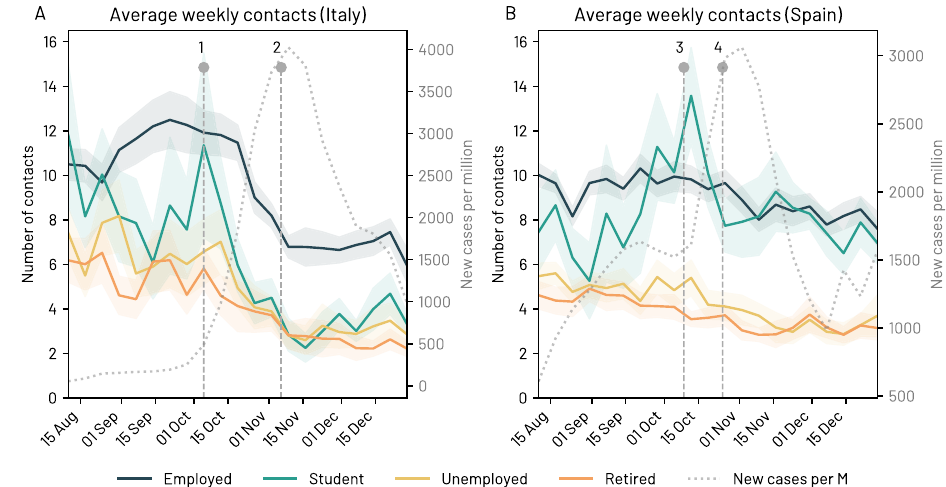
Figure 2. Average estimated number of weekly close contacts from outside the household together with the number of daily coronavirus infections (dotted curve) in Italy (A) and Spain (B) . We highlight in the plots several notable events: (1) the Italian compulsory mask mandate in public spaces; (2) the imposition of the three-tiered system in Italy; (3) the Spanish declaration of state of alarm in the Comunidad de Madrid; and (4) the declaration of state of emergency in Spain. We report the 95% confidence interval to ease the comparison of the